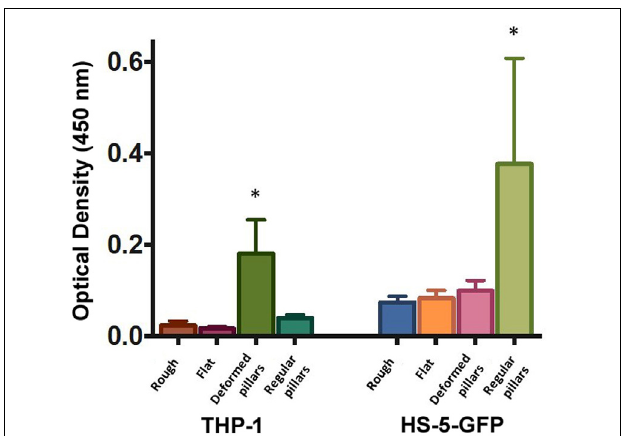
FIGURE 5 | Cell viability as measured by the WST-8 assay using: THP-1 and GFP-HS-5 cells after 48 h of incubation on rough (Rough), flat (Flat), PCL surfaces and integrating regular (Regular pillars) and deformed micropillars (Deformed pillars). Data were expressed as mean ± standard error ( n = 3). ∗ Represents the statistically significant difference when the group is compared with the other of the same cell line ( p <